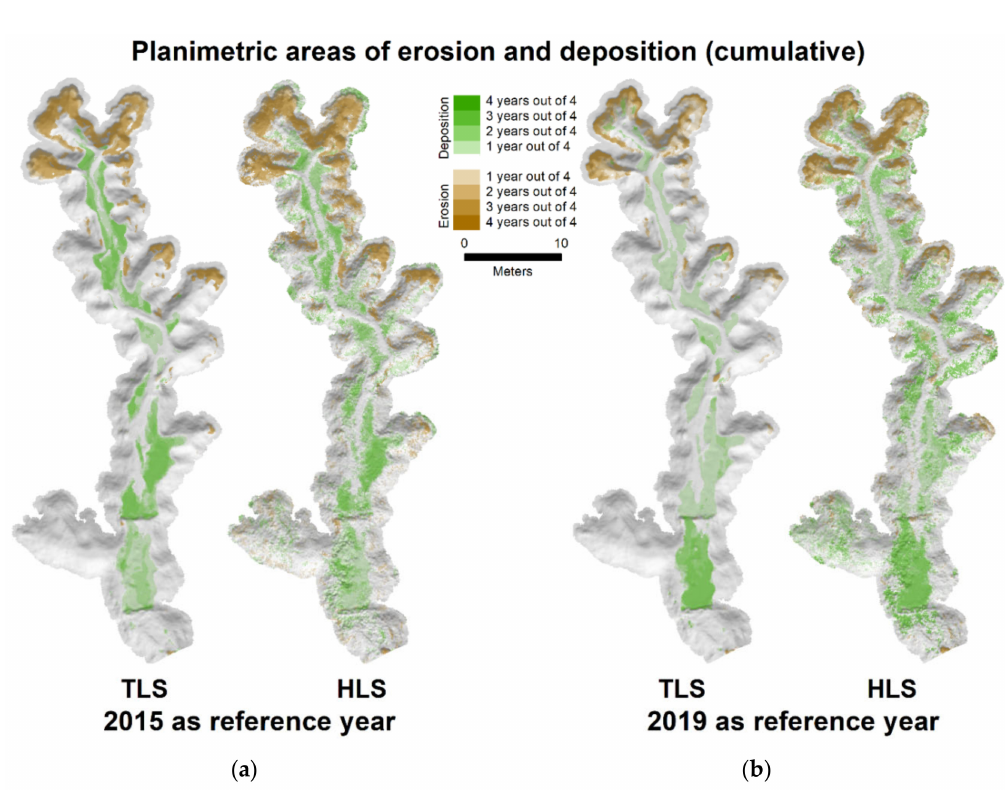
Figure 8. Cumulative areas of erosion (brown) and deposition (green) for TLS and HLS as detected in DEMs of difference using 2015 ( a ) and 2019 ( b ) as reference years. Darker colours are changes that were detected over all yearly intervals, pale colours are changes that were detected in only one year. Some of the deposition areas were associated with the check dams installed on the gully